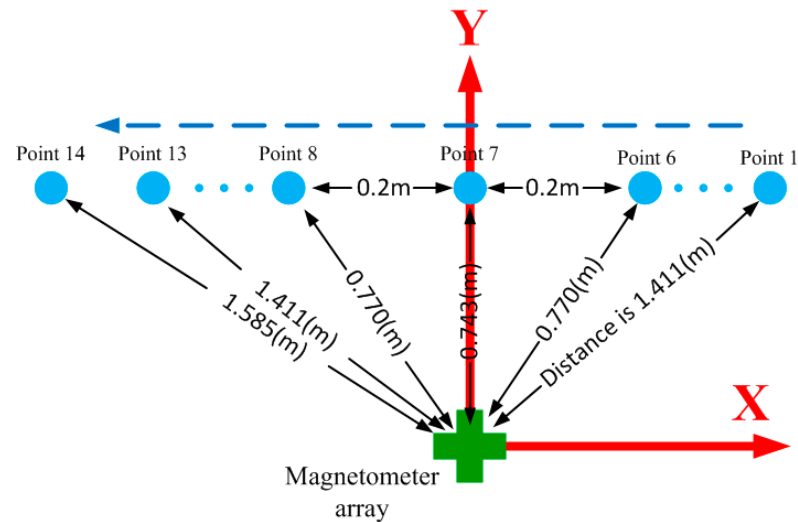
Figure 7. The diagram of the object trajectory.